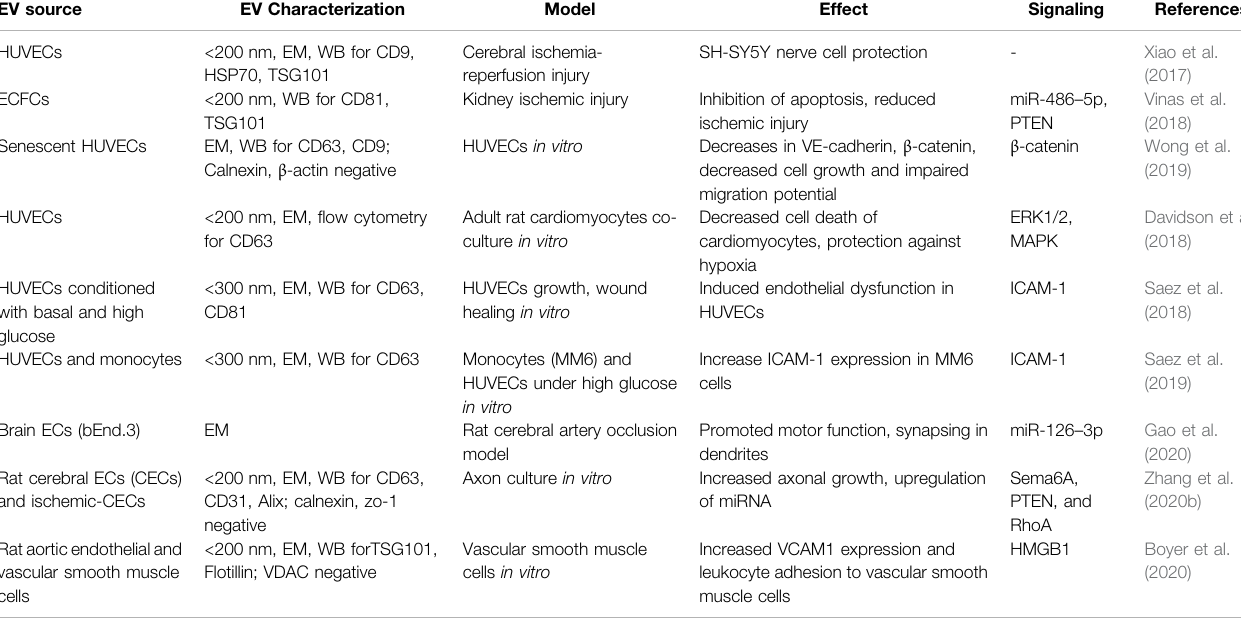
TABLE 2 | The biological effect of endothelial cell-EVs on organ and cell repair in various non-radiation injury